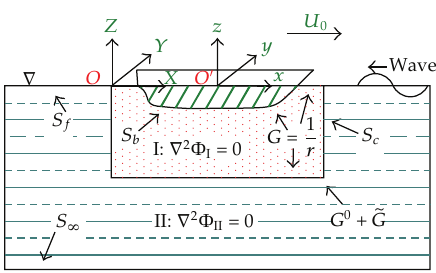
Figure 1: Coordinate system definition and decomposition of the fluid